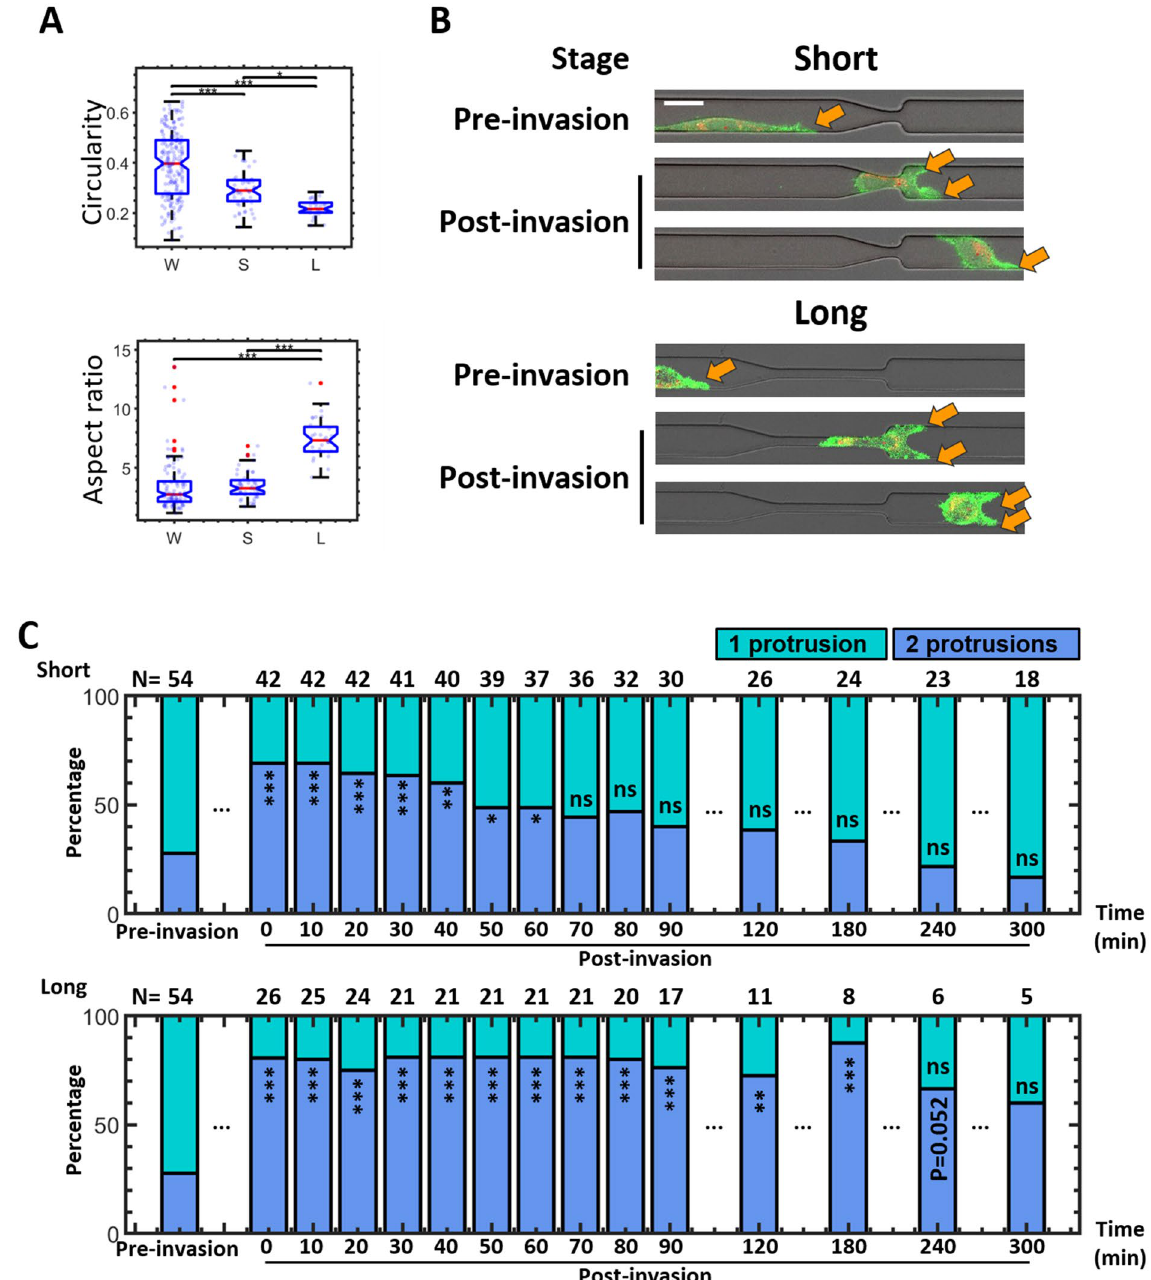
Figure 4. Impact of geometric confinement on cancer cell protrusion formation. ( A ) Circularity (upper) and aspect ratio (lower) are used to compare cells in the wide (W, N = 195), short constriction channel (S, N = 50), and long constriction channel (L, N = 32). ( B ) The representative cell images show cell protrusion formation at the leading edge when migrating through a short (left) or a long (right) constriction channel from pre-invasion to post-invasion stage. The arrows indicate the protrusions. Scale bar = 20 μm. ( C ) The composition of cells with 1 or 2 protrusions over time is used to show protrusion dynamics. Cells are categorized based on their leading edge protrusion number at each time point. The upper is cells that migrate through the short constriction channels, and the lower is cells that migrate through the long constriction channel. The legends show the category of cell protrusion number. The N number above each bar is the sample number used at each time point. The y-axis is the percentage of the cells with corresponding leading edge protrusion numbers. The composition of protrusion at each time point of post-invasion is compared with pre-invasion